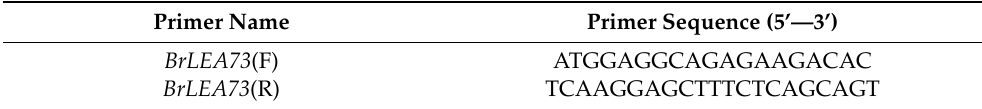
Table 2. The primer sequences for PCR